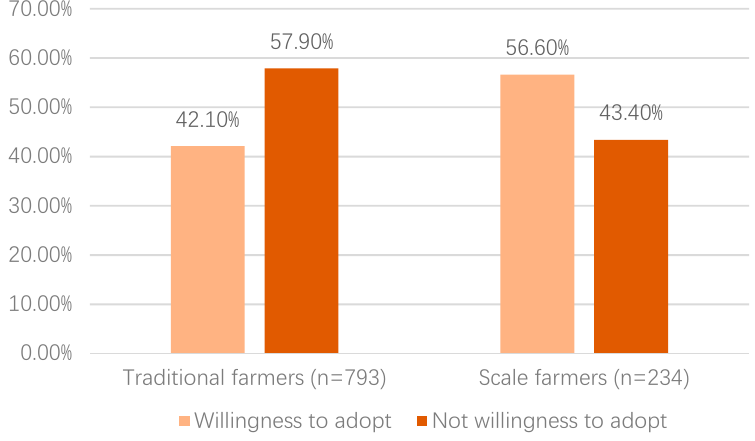
Figure 3. The proportions of the willingness to adopt WSI for different scale farmers.